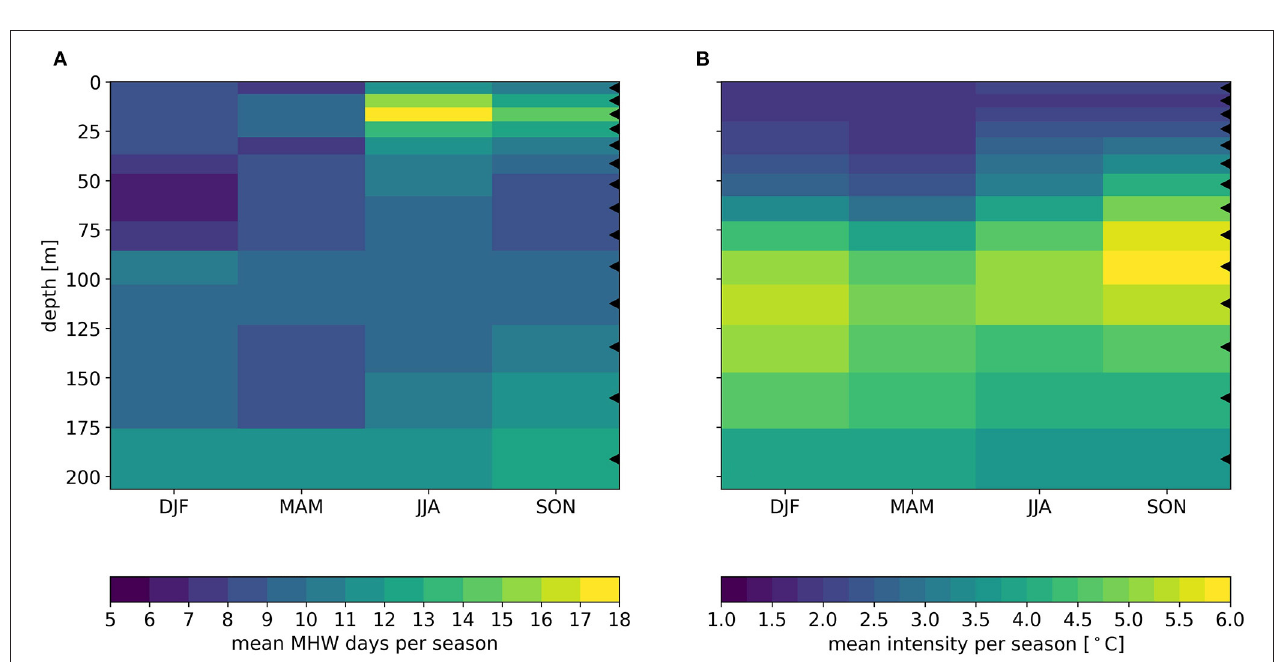
FIGURE 8 | Co-variability of heat and salinity extremes and general anomalies; percentage of MHW (MCS) days coinciding with a saline (fresh) extreme for each depth level (A) [salinity extreme detection with the same mechanism as for MHWs (MCSs)]; temperature-salinity-plot for anomalies (B) for all the data; MHW (positive temperature anomalies) and MCS (negative temperature anomalies) points are colored by their depth; note that MHW and MCS points can overlay gray points with large anomalies, though they are not detected as extremes given the season and/or depth.